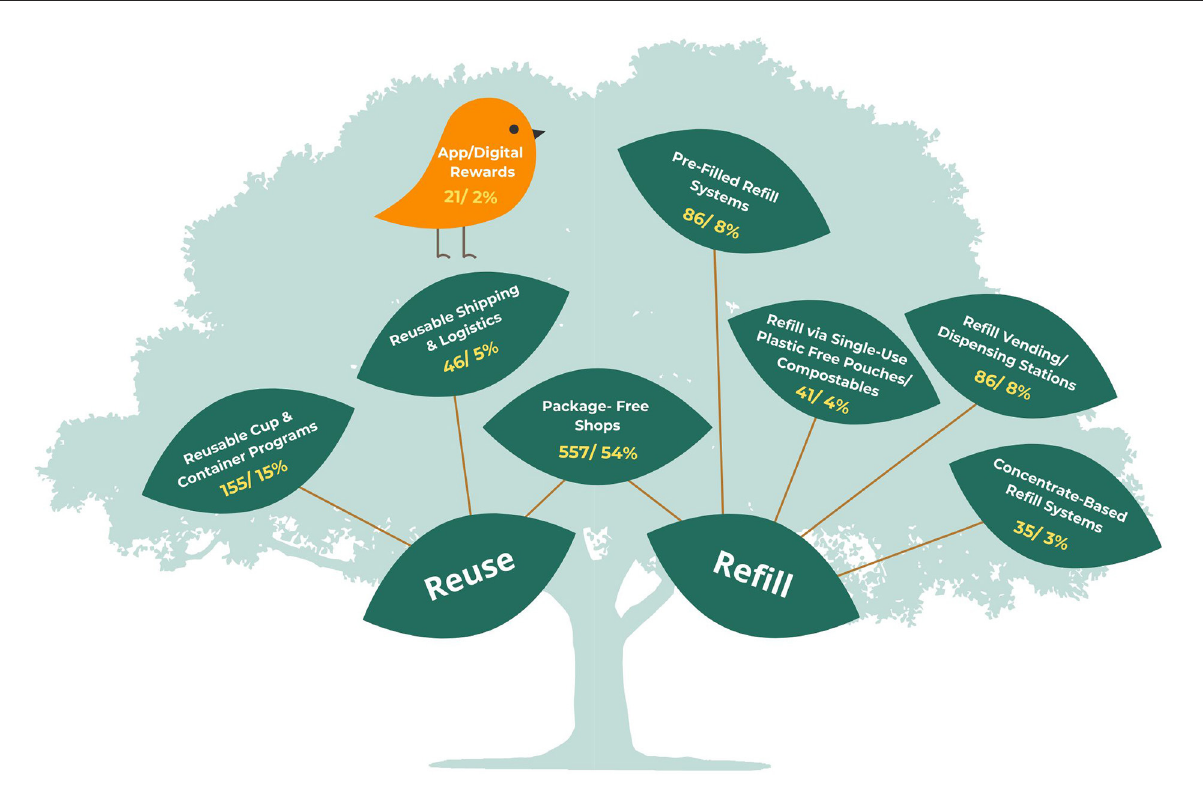
FIGURE1 Overview of landscape of reuse and refill solutions by type and